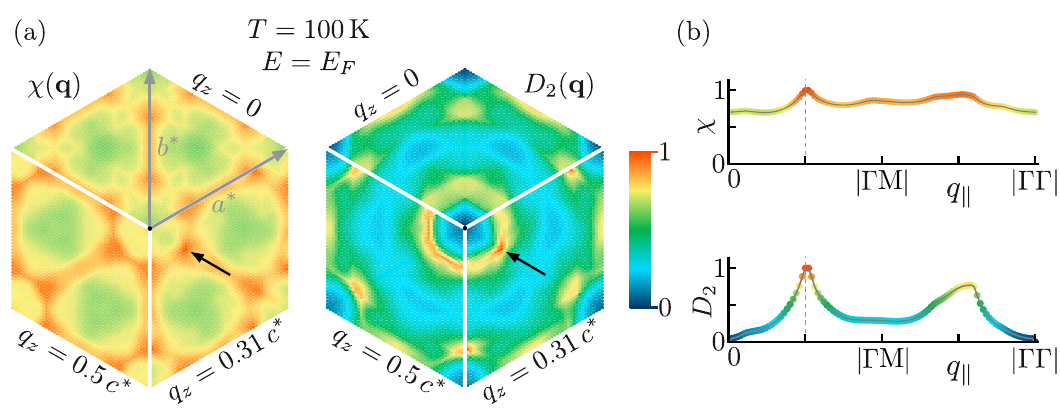
Figure 2: (a) The Lindhard function χ ( q ) (left) and the structured susceptibility ( q ) (right) at T = 100 K as a function of in-plane q = 0 indicated by D (cid:107) (with q (cid:107) 2 the black dot), at various values of q . Both graphs are normalised to their respec- z tive maxima, which lie around q = ( 0,0.25,0.31 ) rlu and symmetry-related positions (black arrows). (b) Line cuts of the Lindhard function and structured susceptibility = 0.31 c ∗ , varying q at q (cid:107) along a line through the black arrows in z